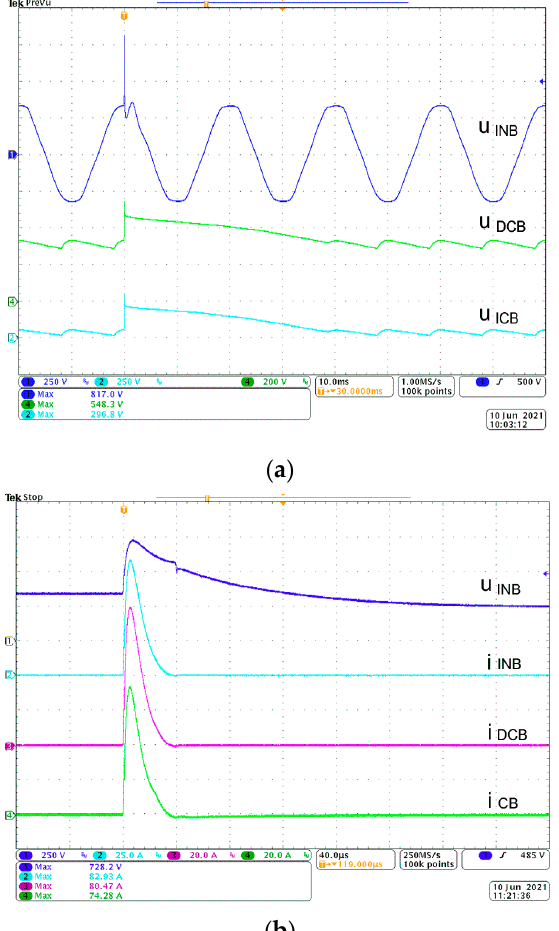
Figure 4. ( a ) Voltage and ( b ) current waveforms at selected test points (marked in Figure 1b) for lamp B for a surge of 1.2/50 µs (8/20 µs) injected at the top of the mains voltage sinusoid.